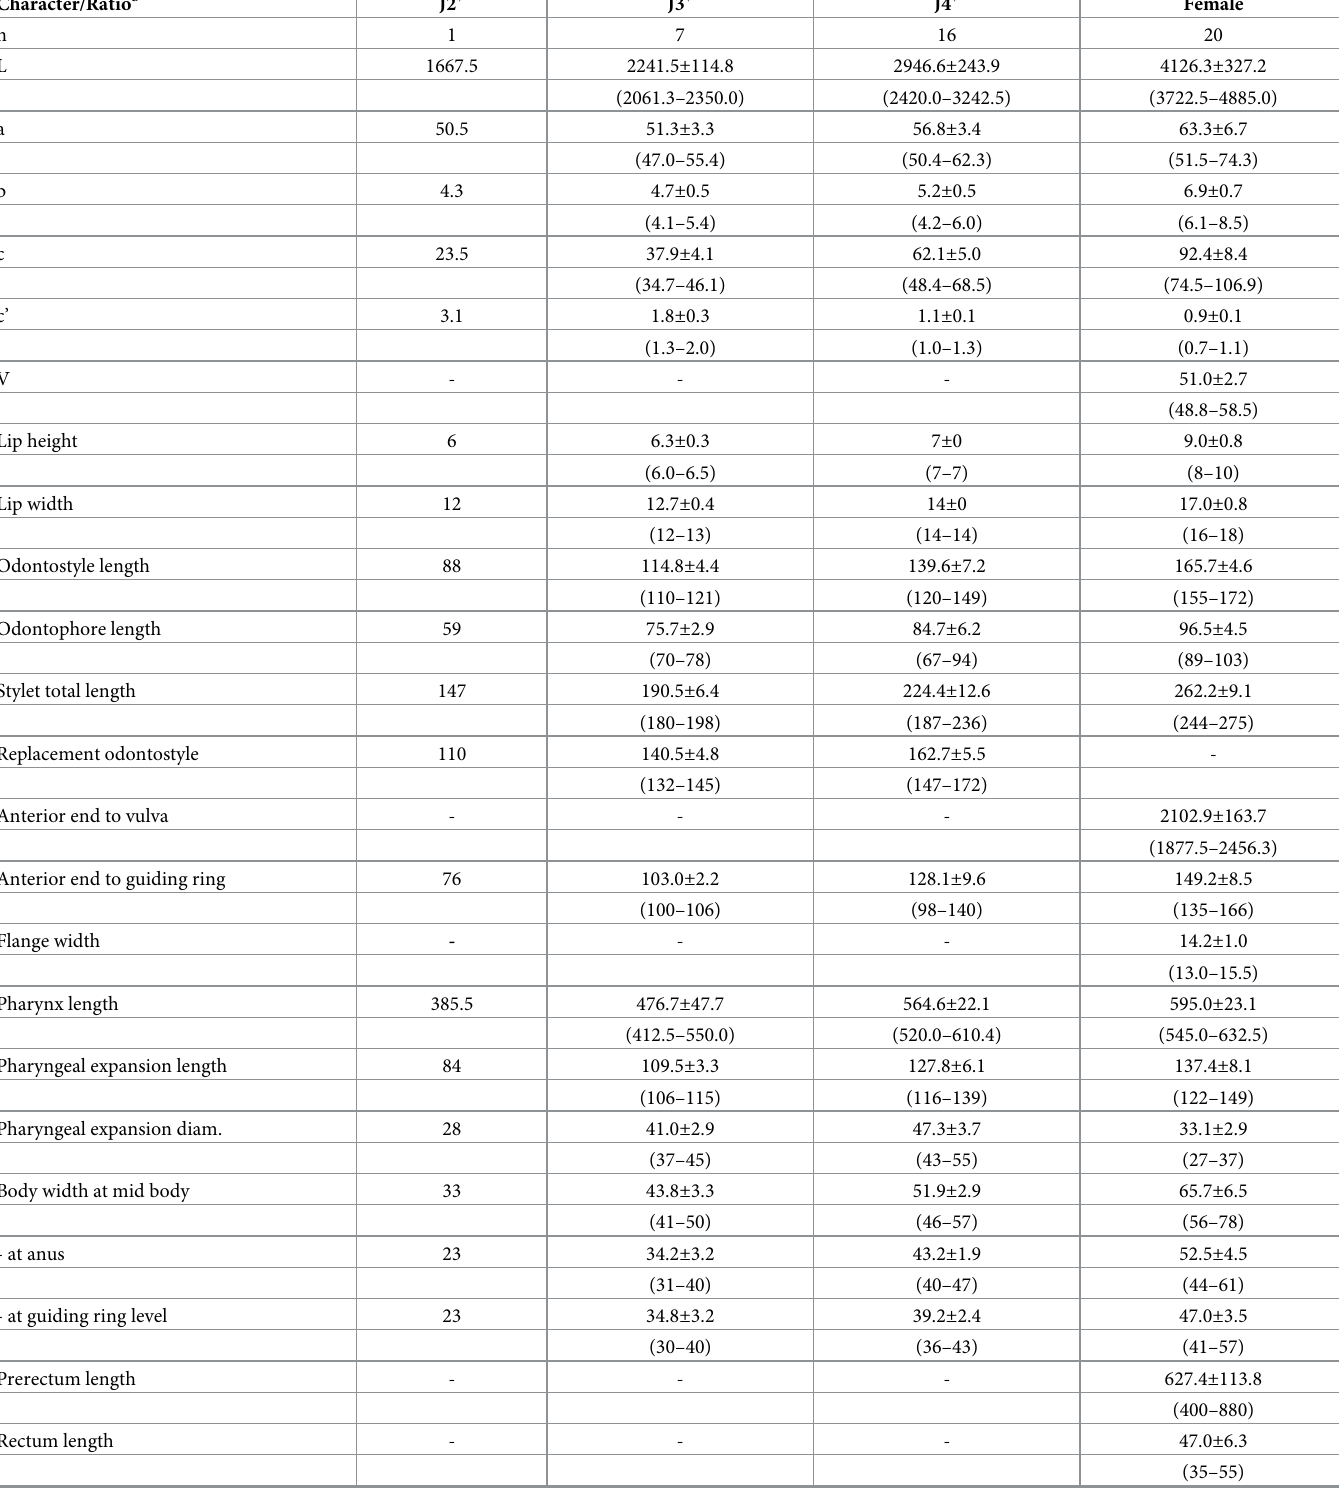
Table 2. Morphometrics of Xiphinema afratakhtehnsis sp. nov. (population with code 764) a